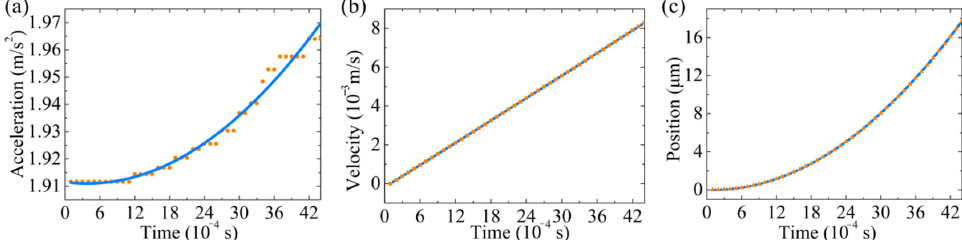
Figure A3. Time evolution of the equation shows the optical pulling behaviour. ( a ) The acceleration, ( b ) the velocity and ( c ) the trajectory of the metalens in the time domain.